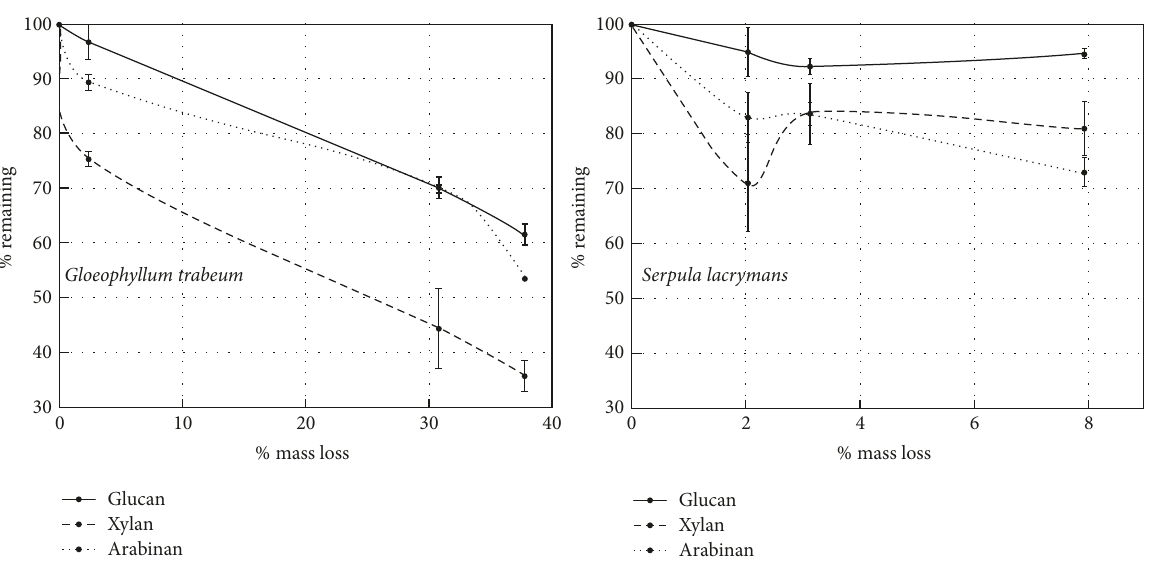
a Standard deviation of three biological replicates is shown in parentheses; b standard deviation of three assays of an extract of 8 sorghum discs is shown in parentheses; c values adapted from Presley and Schilling 2017.